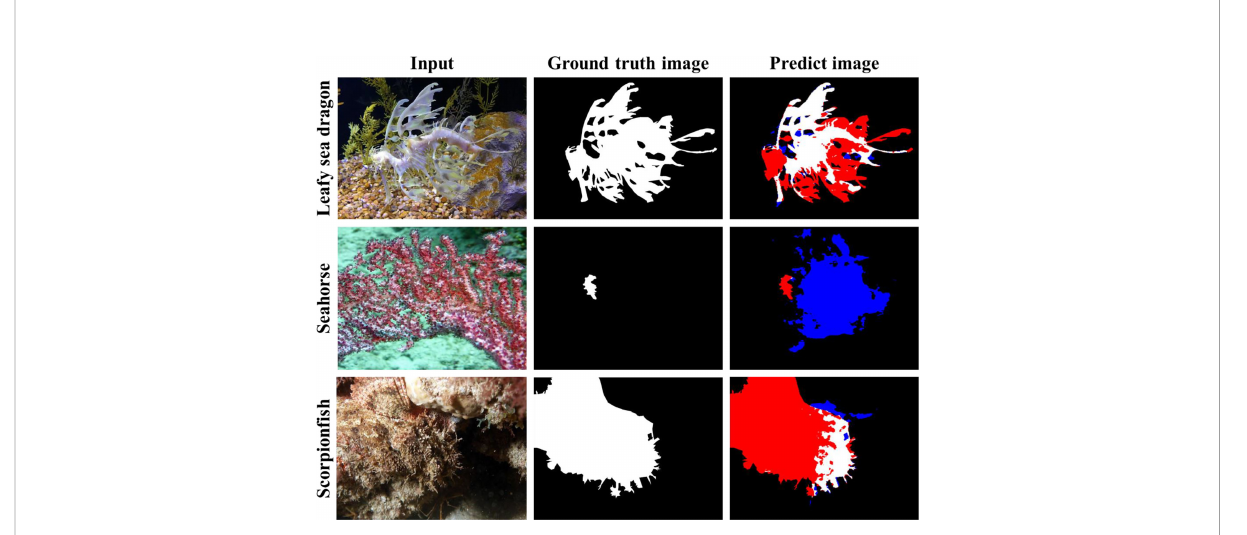
FIGURE 9 Examples of error cases for complex objects. TP, FP, FN, and TN are denoted in white, blue, red, and black colors,